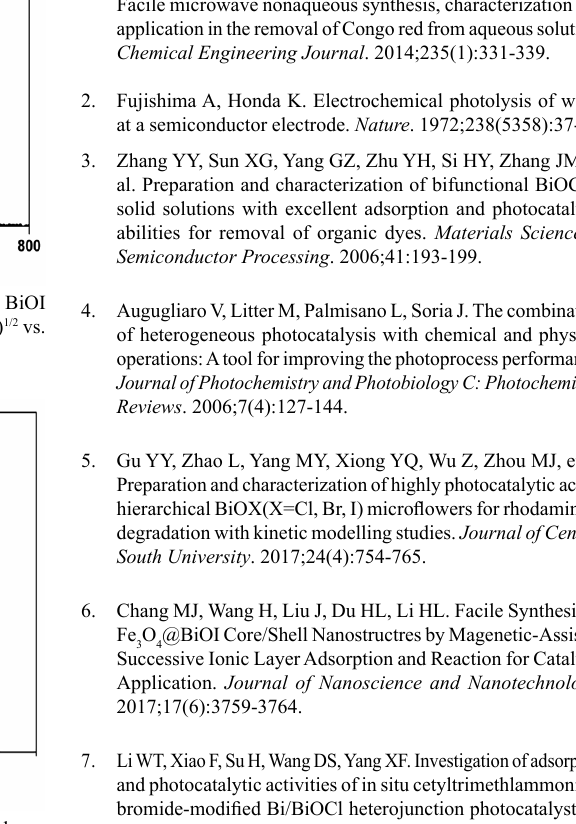
Figure 8. Recycling test of the RhB-adsorbed BiOI microspheres performed on adsorption-regeneration